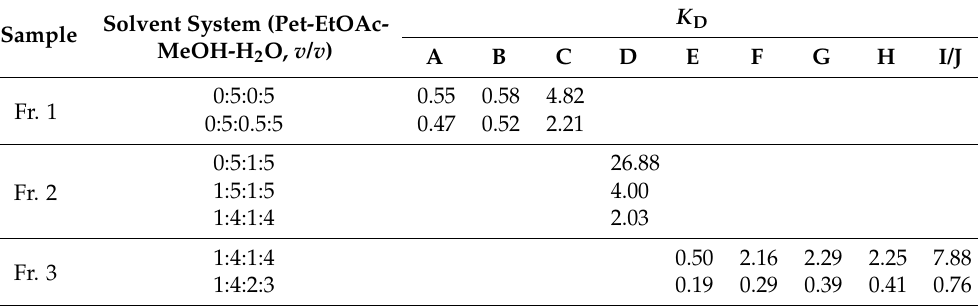
Table 1. The K D values of caffeoylquinic acid derivatives from burdock